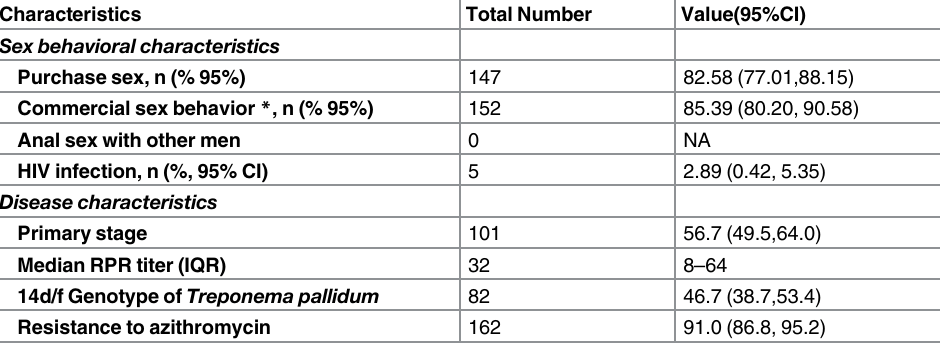
* Commercial sex behavior: exchange sex behavior for things like money, drugs, or other resources, the